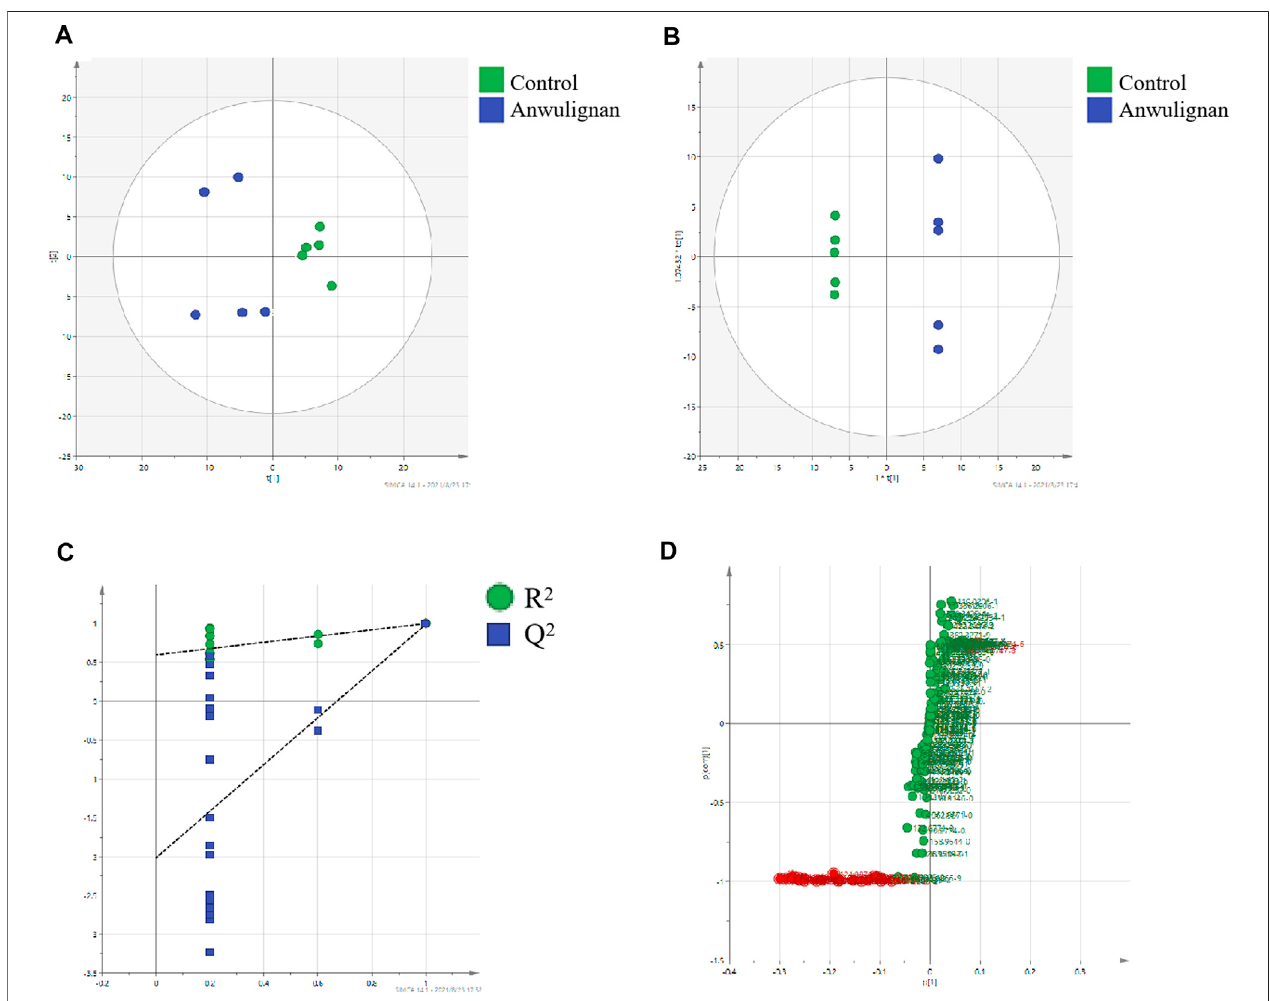
FIGURE 5 | Multivariate statistical analysis control and anwulignan group: (A) PCA score plot; (B) OPLS-DA score plot; (C) cross-validation plot of OPLS-DA model; and (D) S-plot of OPLS-DA.